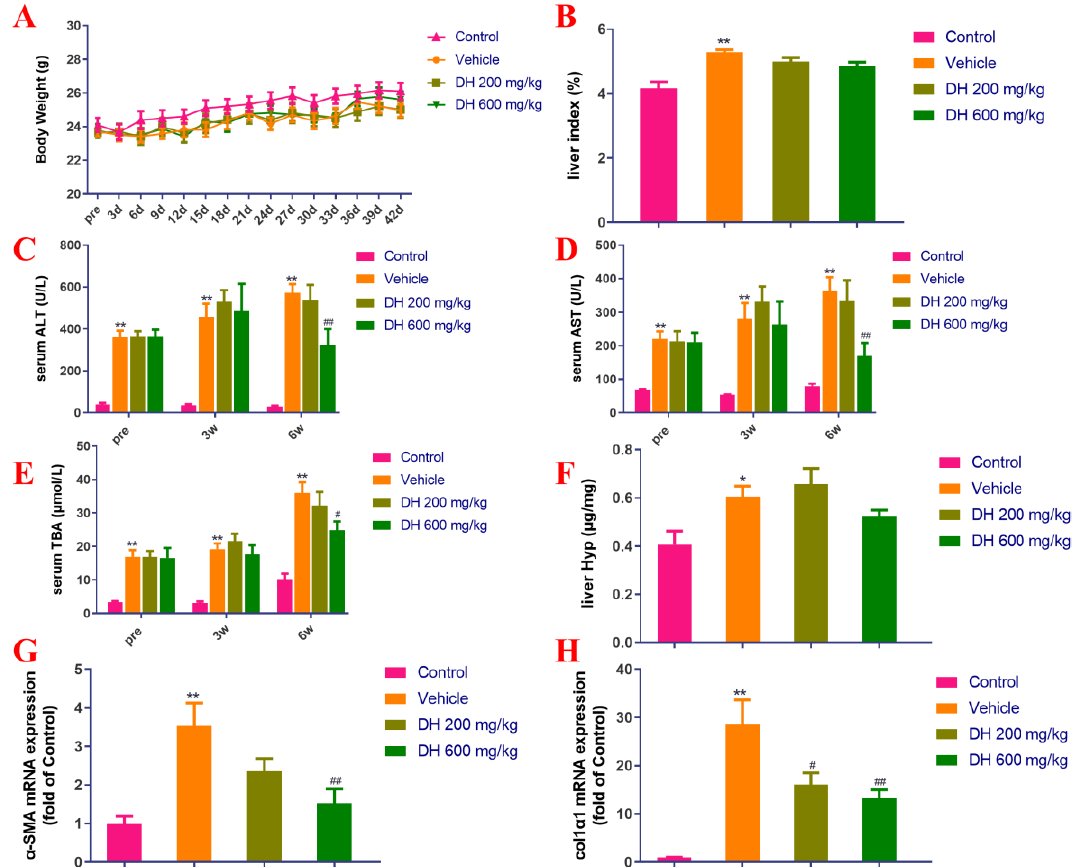
Figure 4. Investigation of the effect of D. heterophyllum treatment on the blood serum levels of ALT, AST, and TBA production, as well as its impact on the gene expression of α - SMA and col1α1 mRNA expression in the CCl 4 -induced liver fibrosis mice. Body weight ( A ), liver index ( B ), serum levels of ALT ( C ), AST ( D ), TBA ( E ), liver levels of Hyp ( F ), α -SMA mRNA expression ( G ) and col1α1 mRNA expression ( H ). Pre: preparation; 3 d – 42 d: 3 days – 42 days; 3W: 3 weeks, 6W: 6 weeks. DH 200 mg/kg: 200 mg/kg ethyl acetate extract; DH 600 mg/kg: 600 mg/kg ethyl acetate extract. Values are presented as the mean ± SD ( n = 10). * p < 0.05, ** p < 0.01 vs. the control group; # p < 0.05, ## p < 0.01 vs. the vehicle group.